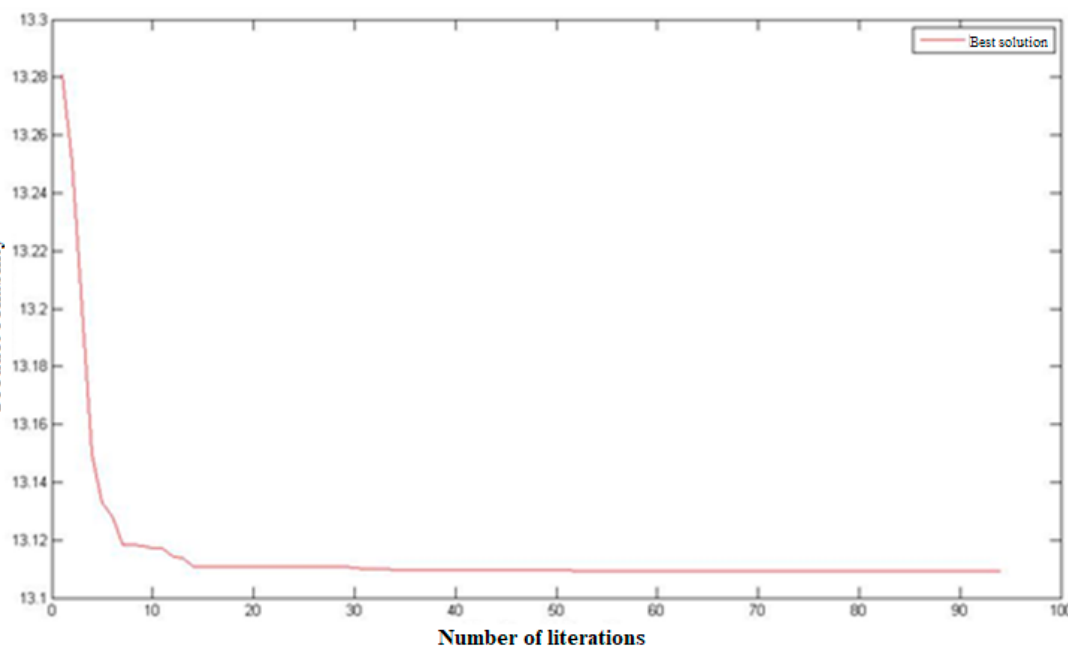
Figure 9. Pareto fronts acquired by the single objective optimization model.